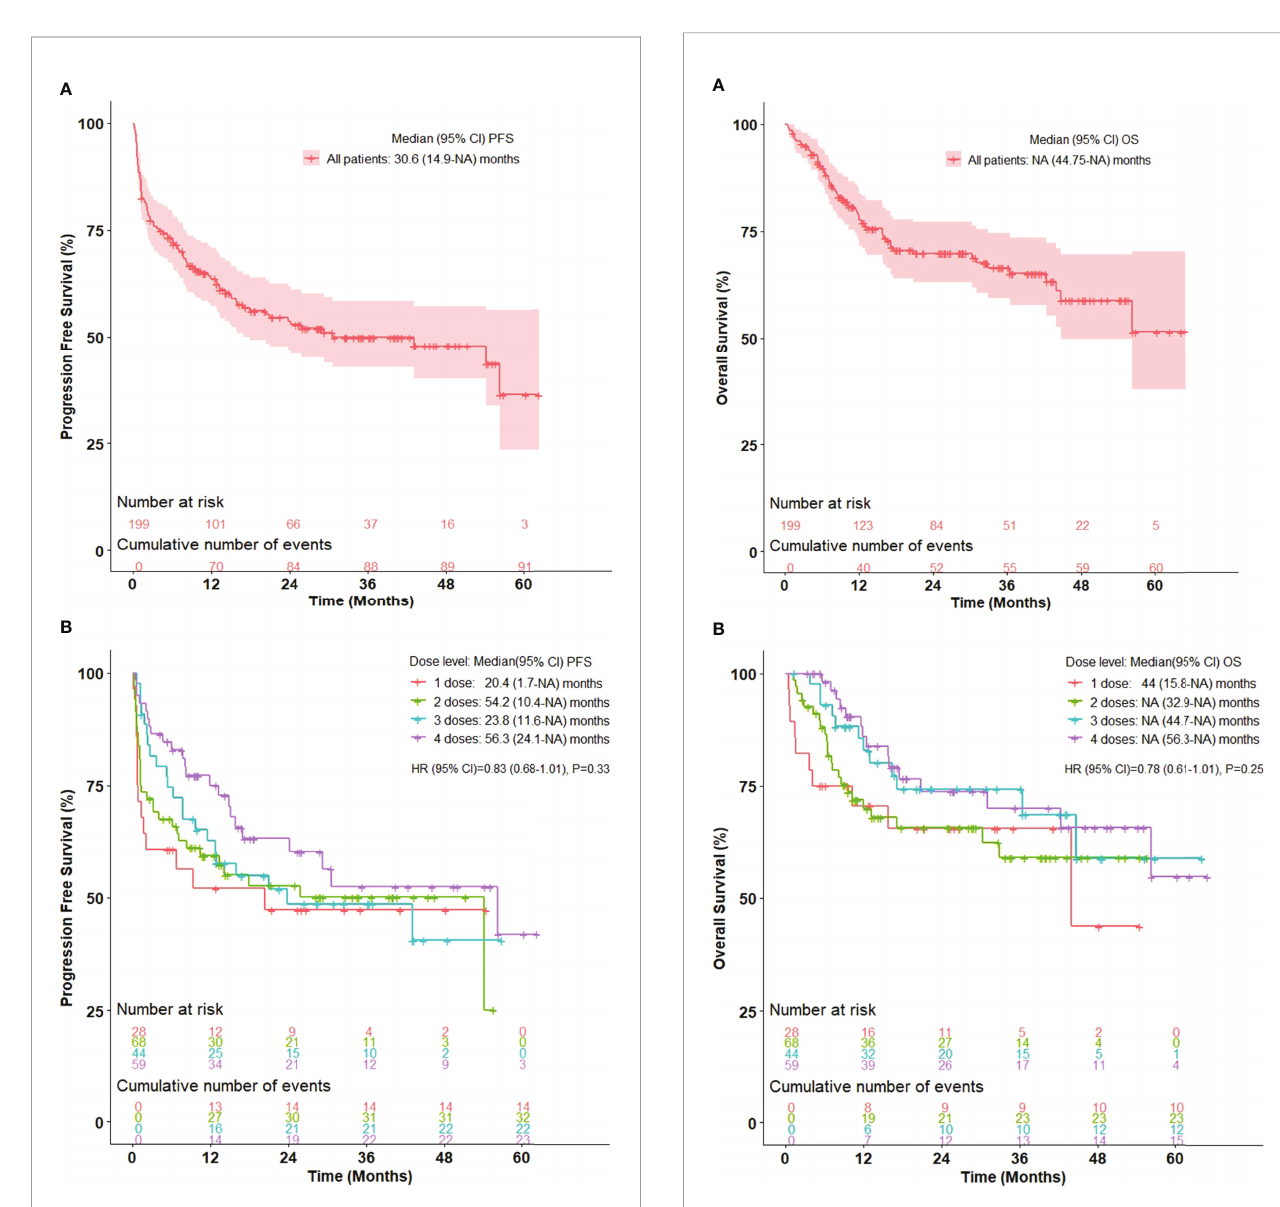
FIGURE 2 | Kaplan-Meier curve for overall survival in advanced stage melanoma patients treated with ipilimumab/nivolumab in (A) all patients and (B) strati fi ed by number of ipilimumab/nivolumab doses received. n =